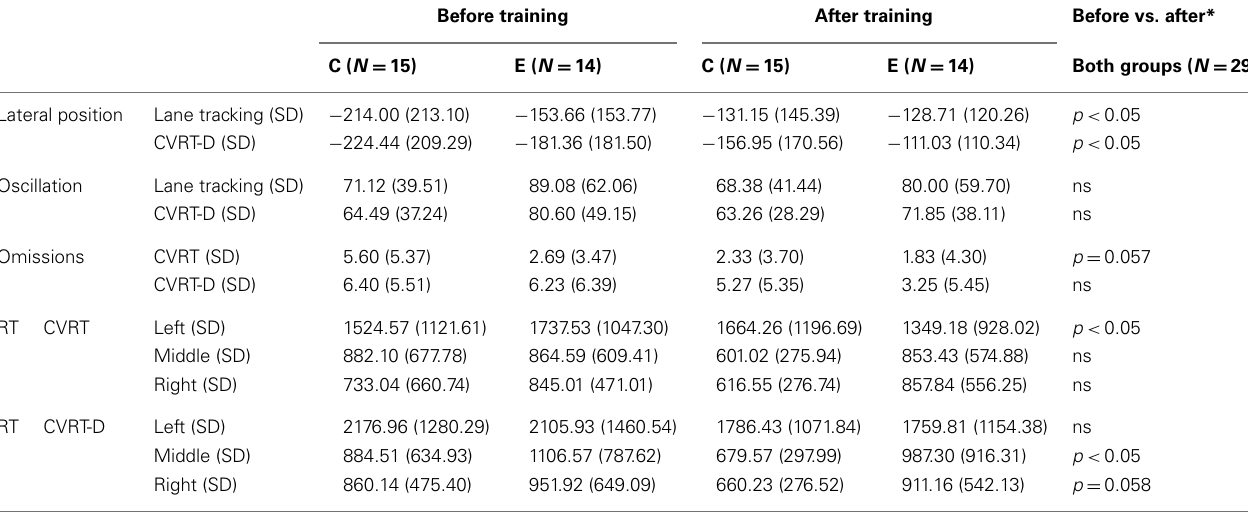
Table 4 | Mean scores and SDs on driving measures before and after training for each group. Before training After training Before vs. after*